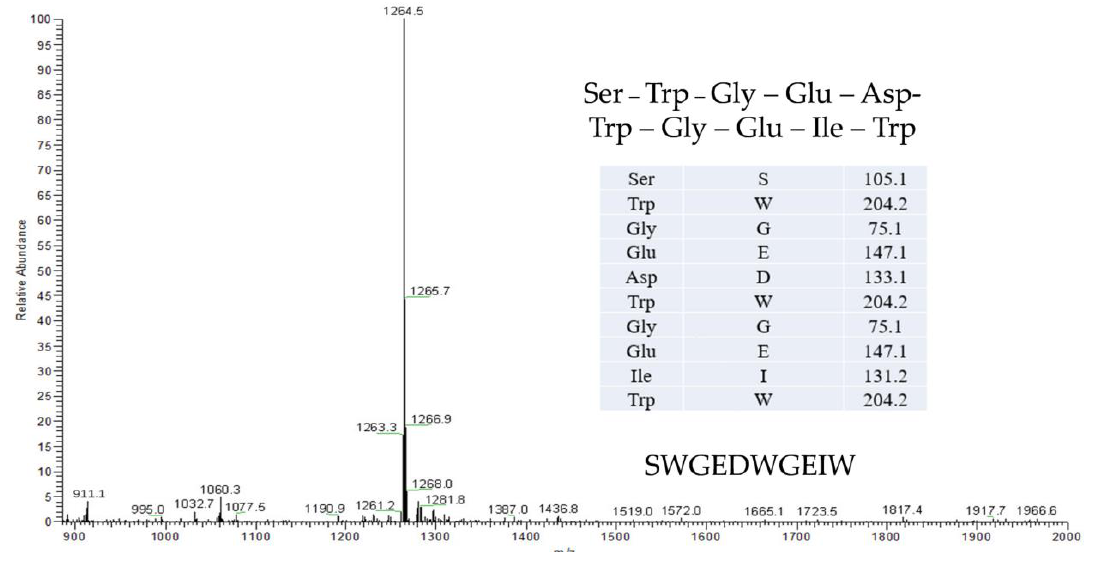
Figure 6. Mass spectra of TSP.